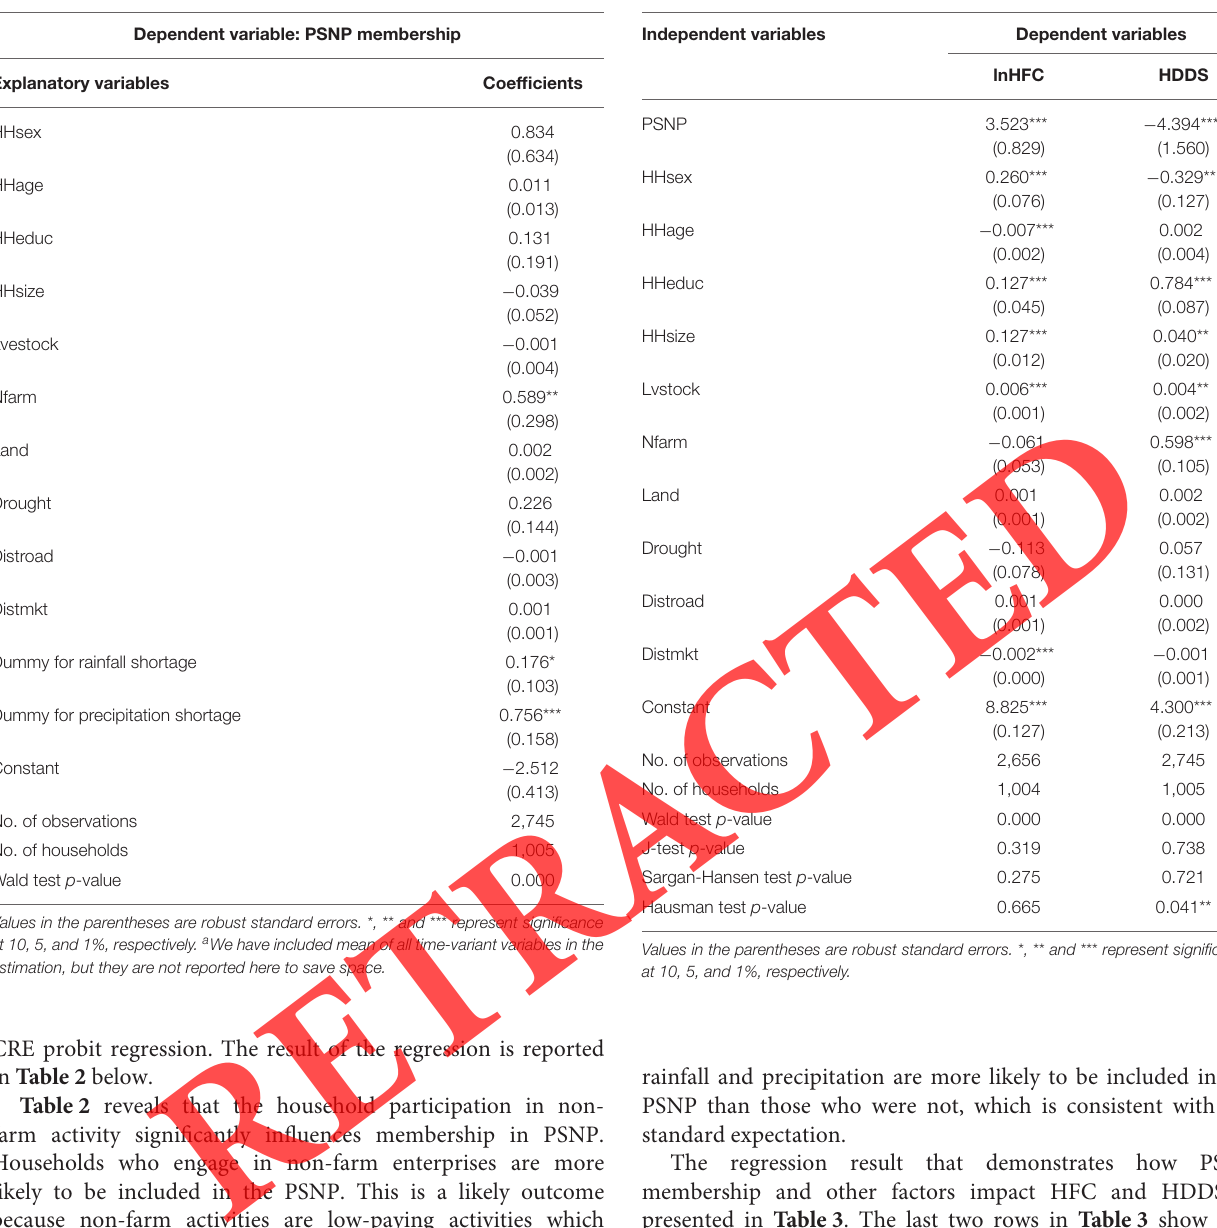
TABLE 2 | CRE estimation result of membership in PSNP a . TABLE 3 | REIV estimation result of HFC and